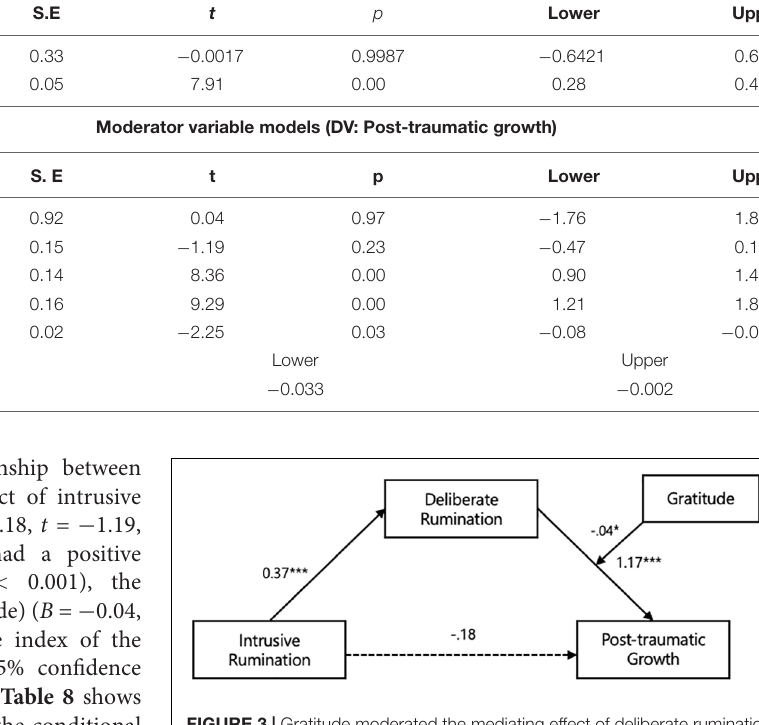
FIGURE 3 | Gratitude moderated the mediating effect of deliberate rumination between intrusive rumination and post-traumatic growth. ∗ p < 0.05, ∗∗ p < 0.01, ∗∗∗ p < 0.001.